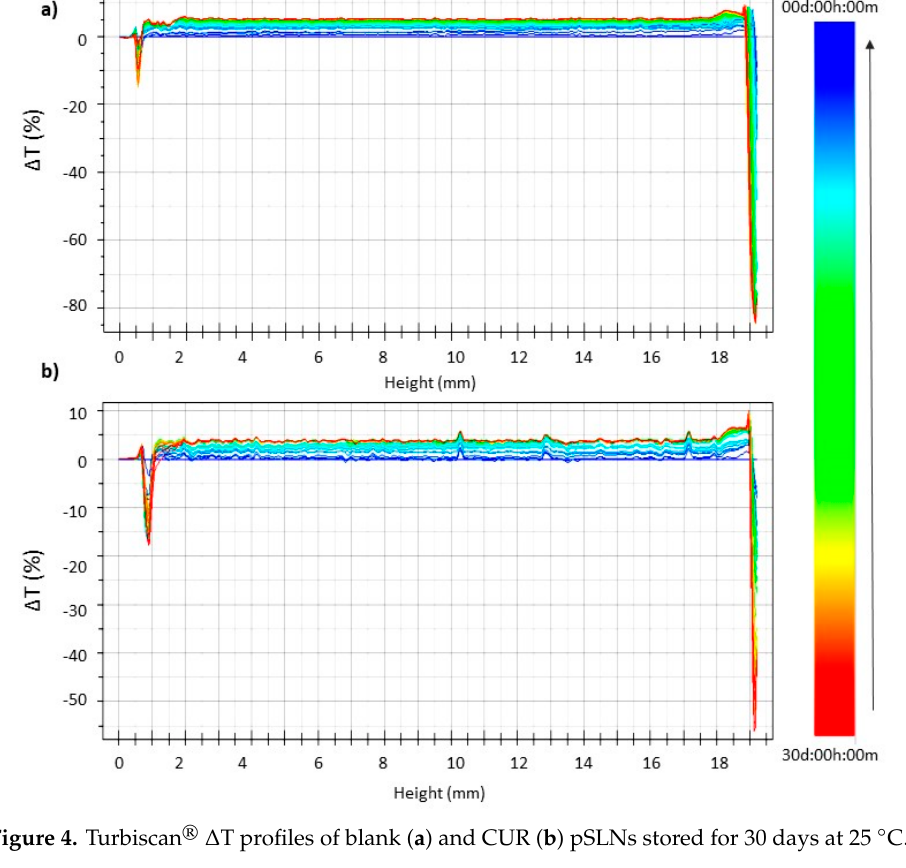
Figure 4. Turbiscan ® Δ T profiles of blank ( a ) and CUR ( b ) pSLNs stored for 30 days at 25 °C.